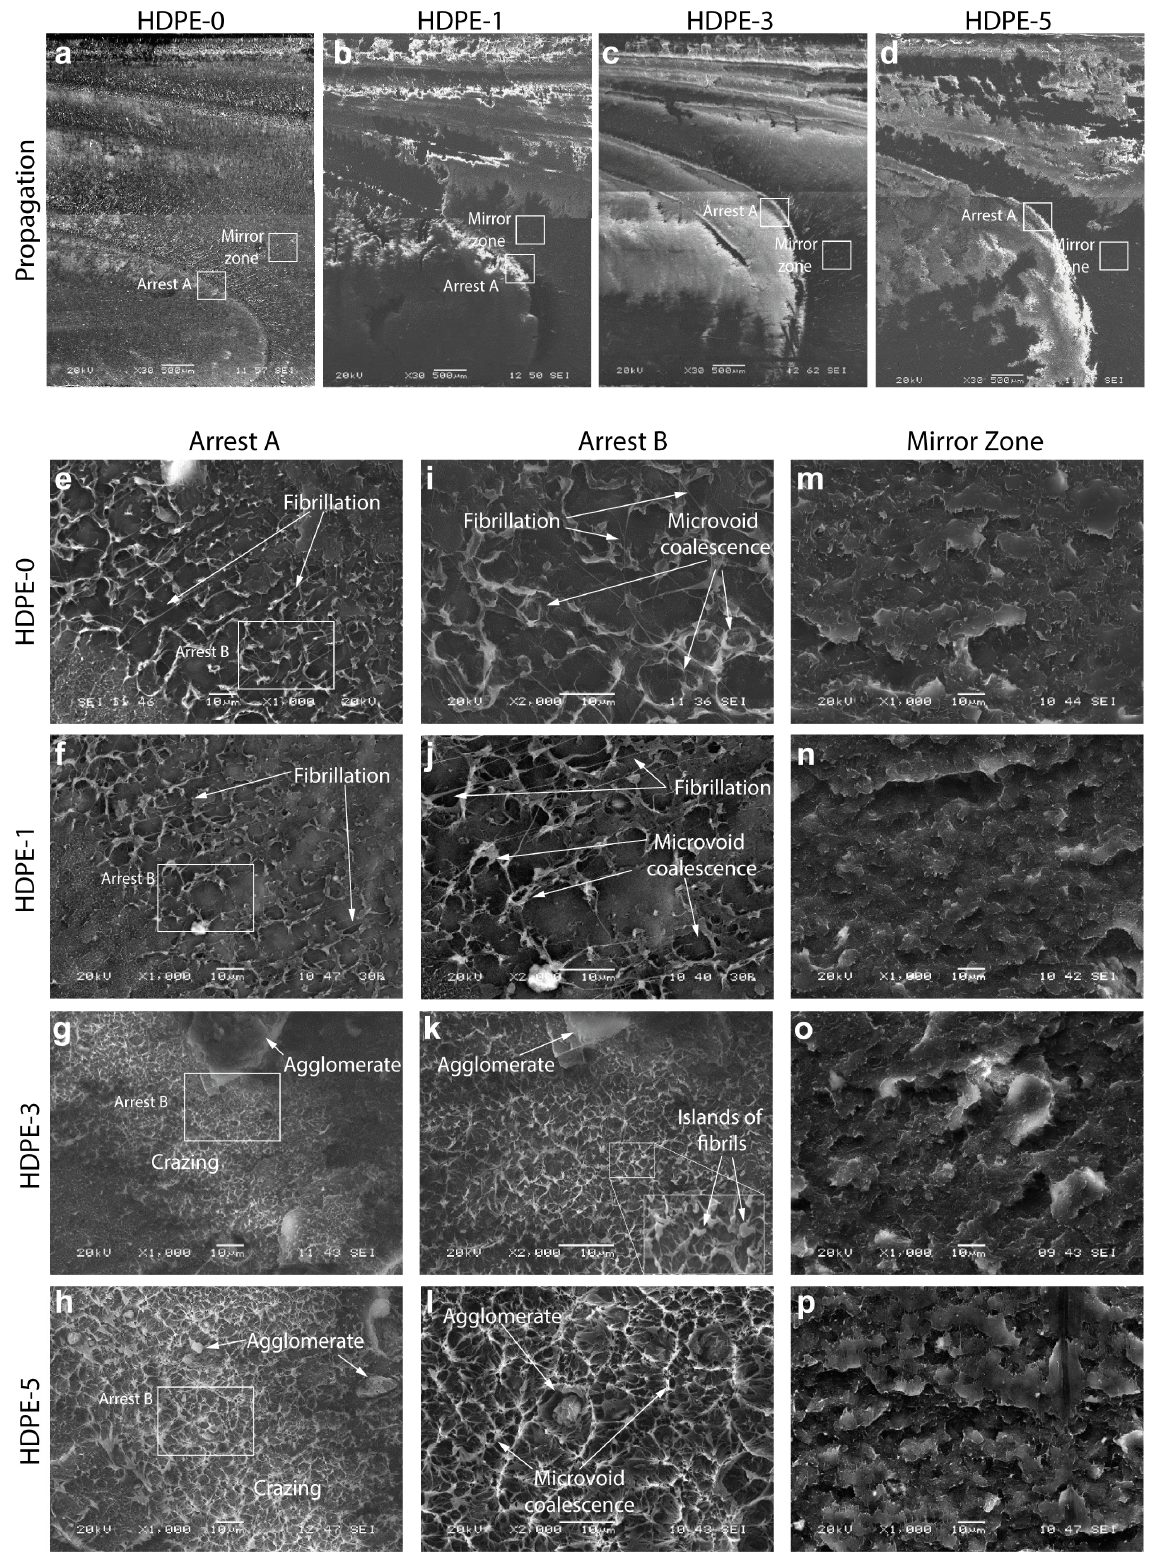
Figure 5. SEM images of the ( a – d ) propagation zone during RCP in the HSDT test specimens for different HDPE–clay nanocomposites (containing 0, 1, 3, and 5 wt% of nanoclay, respectively), and magnifications at ( e – h ) arrest zone A, ( i – l ) arrest zone B, and ( m – p ) the mirror